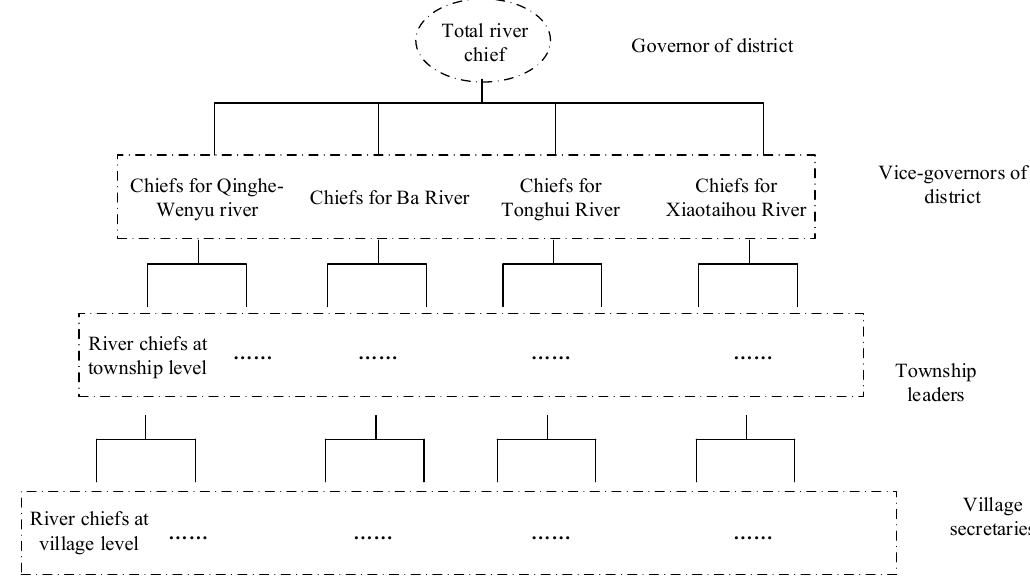
Figure 8. Responsibility division system for river chiefs at different levels in Chaoyang district.